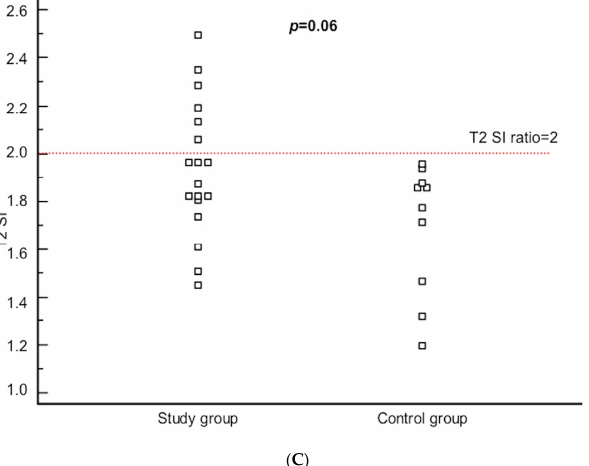
Figure 2. Examples of cardiac magnetic resonance images in mid-ventricular short axis views demonstrating signs of myocardial oedema in patients with RA and lack of those in controls: T1 pre-contrast time ( A , D ), T2 time ( B , E ), and T2 SI ratio ( C , F ).